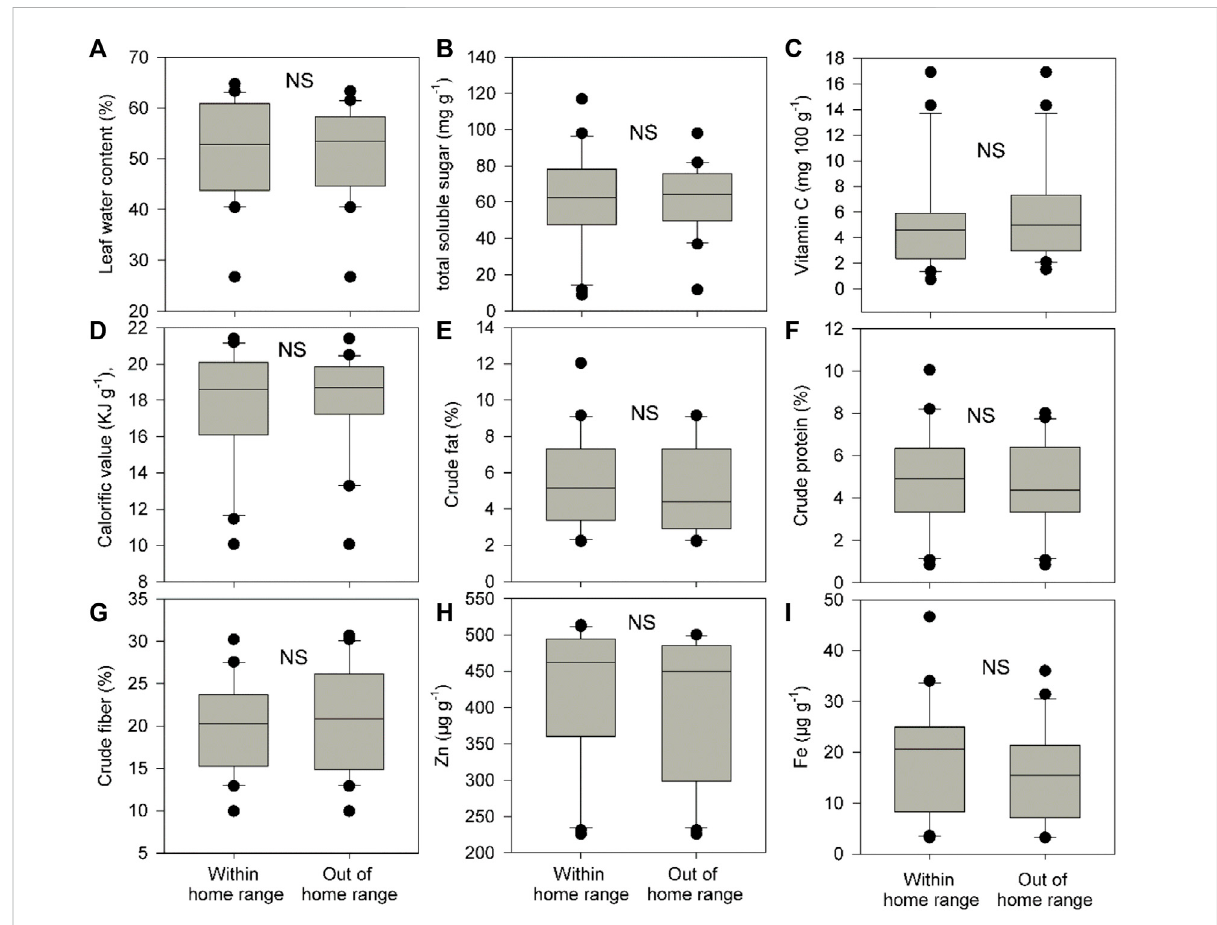
FIGURE 3 Differences in community weighted mean values (CWM) for nine food plant nutrient traits (A-I) between within and out of the home range of group C. These nine traits include leaf water content (%), total soluble sugar (mg g − 1 ), vitamin C (mg 100 g − 1 ), calori fi c value (KJ g − 1 ), crude fat (%), crude protein (%), crude fi ber (%), Zn ( μ g g − 1 ), and Fe ( μ g g − 1 ). Box plots show the median (line within the box), 25th and 75th percentiles (the boundariesofthebox),and90thand10thpercentiles(errorbars)ofCWMforfoodplantleafnutrienttraits.NSindicates p > 0.05andshownare results from Wilcoxon signed rank